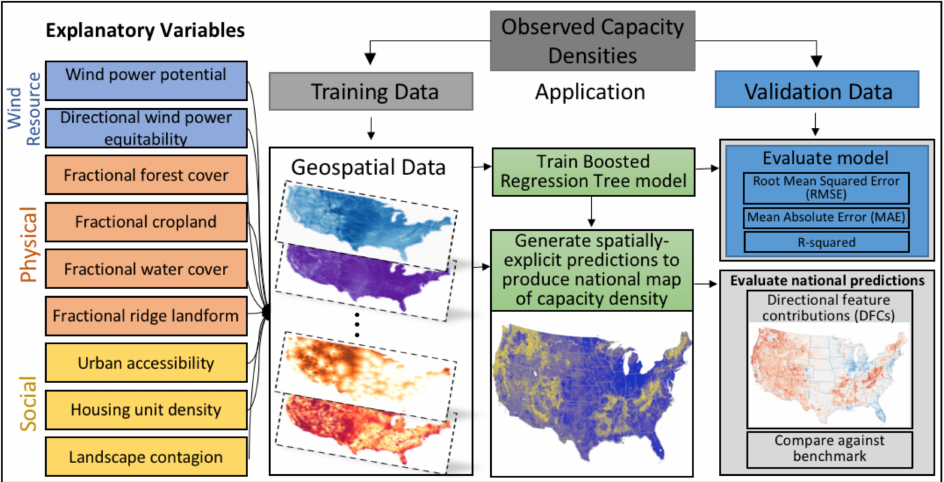
Figure 2. Schematic showing the data-driven workflow used to generate spatially-explicit predictions of capacity density for the United States (U.S.). We compile observed capacity densities for a comprehensive set of operational wind farms in the U.S. and associate those with geospatial variables characterizing physical, social, and environmental drivers that explain geographic variation in capacity density. The boosted regression tree model is trained using a subset of the observations and validated against independent test data to assess its ability to generalize to other locations. We use the validated model to generate a national map of capacity density and apply evaluation techniques to interpret and compare our predictions against a standard benchmark that assumes spatially-uniform capacity densities. Workflow visualization inspired by Lee et al.